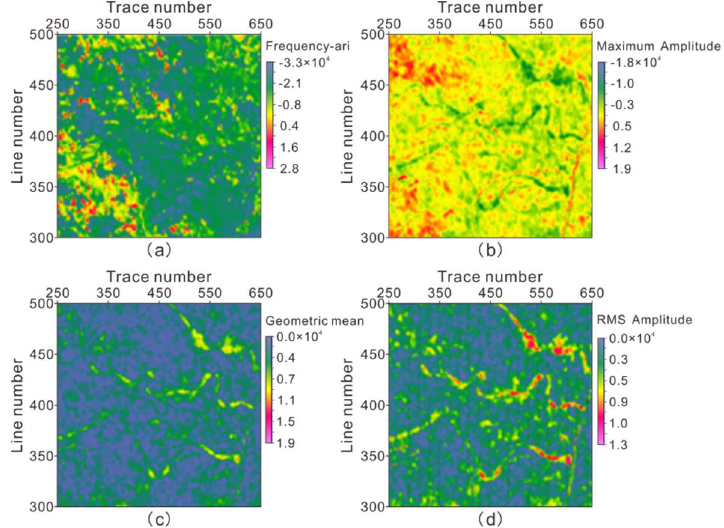
Figure 6. The result of Seismic Attribute Analysis. ( a ) The attribute of frequency, ( b ) The attribute of maximum amplitude, ( c ) The attribute of geometric mean, ( d ) The attribute of RMS amplitude.